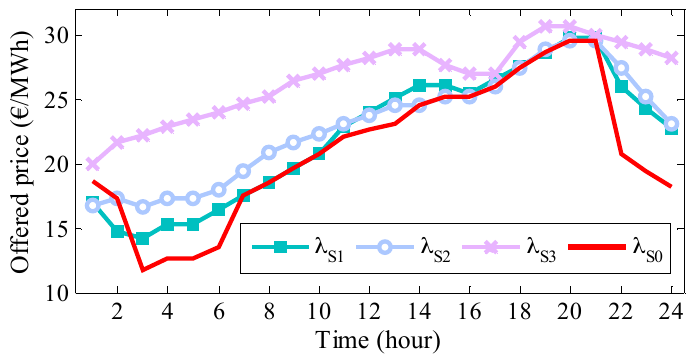
Figure 13. Price offered to the EV owners by the aggregators.